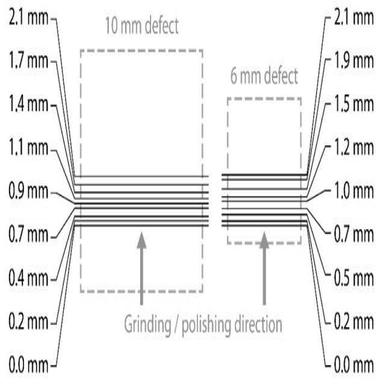
Relative location of each cross-section for both microscopy specimens.